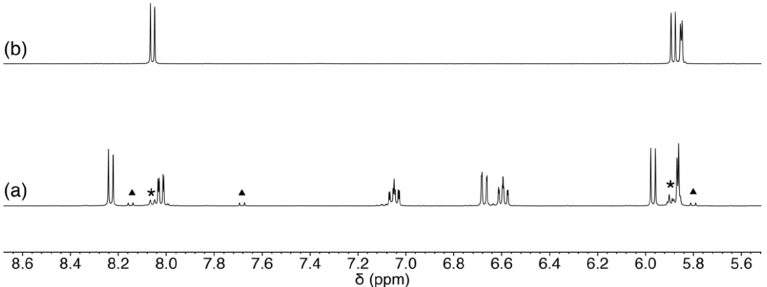
Figure 6. 1 H NMR spectra of ( a ) the reaction mixture of 1 and cytidine, ( b ) cytidine in CD 3 OD. The resonances from a minor product and unreacted cytidine are marked with triangles and asterisks, respectively.